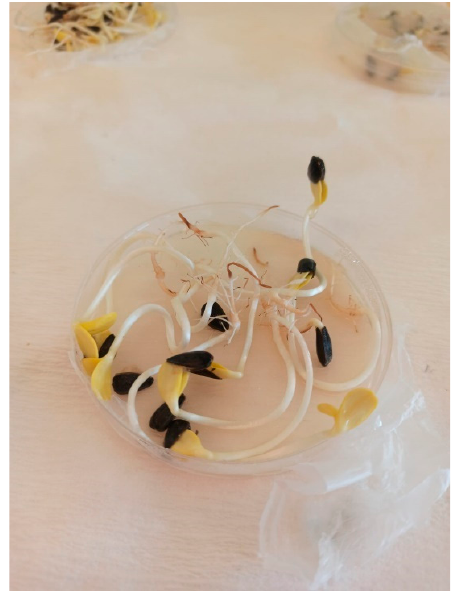
Figure 1. Photos showing seed germination at 25 °C in PD. At this temperature, both germination and seedling development were observed to be at a high level. and seedling development were observed to be at a high